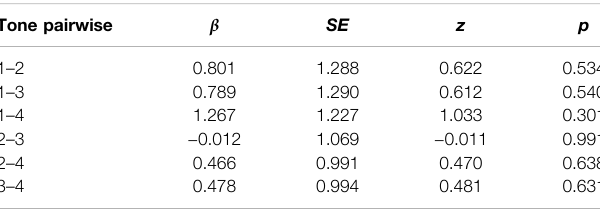
TABLE 7 | Tone comparison results under the condition of nasal. Tone pairwise